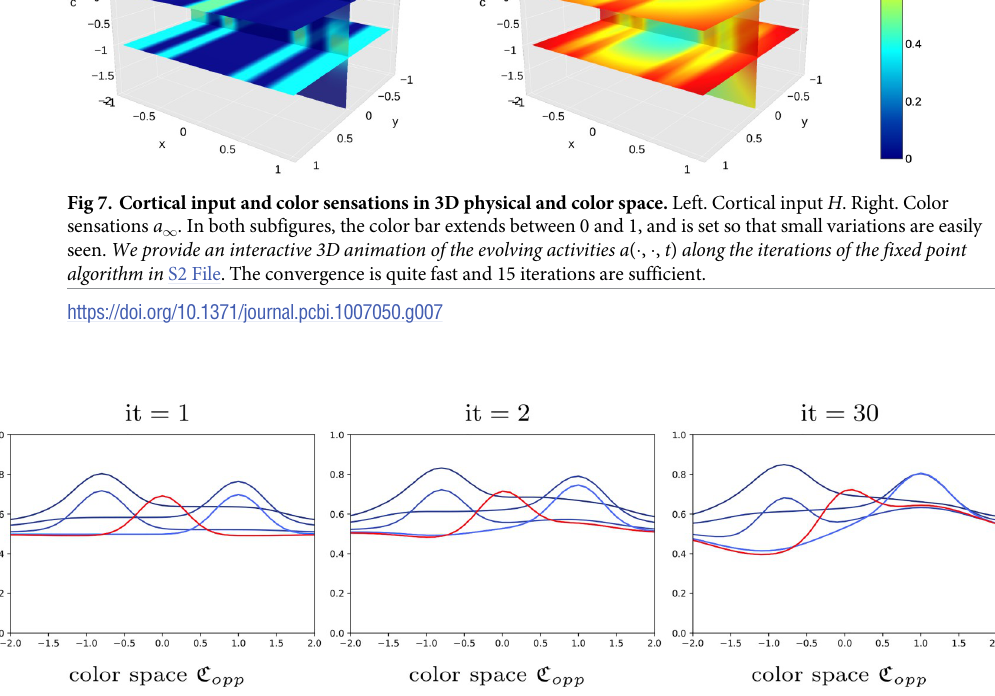
Fig 8. Dynamics of the color neural field Eq (3). The neural activities are plotted after a. one, b. two, c. thirty iterations, and convergence is reached after fifteen iterations. The red curve indicates the activity a test test stripe. Other blue curves correspond to spatial points r i located on surrounding stripes. Notice that only four and not eight different curves are seen, because of the axial symmetry artificially introduced to facilitate numerical computations, as explained in S2 Appendix. A video of the dynamics is provided in S1